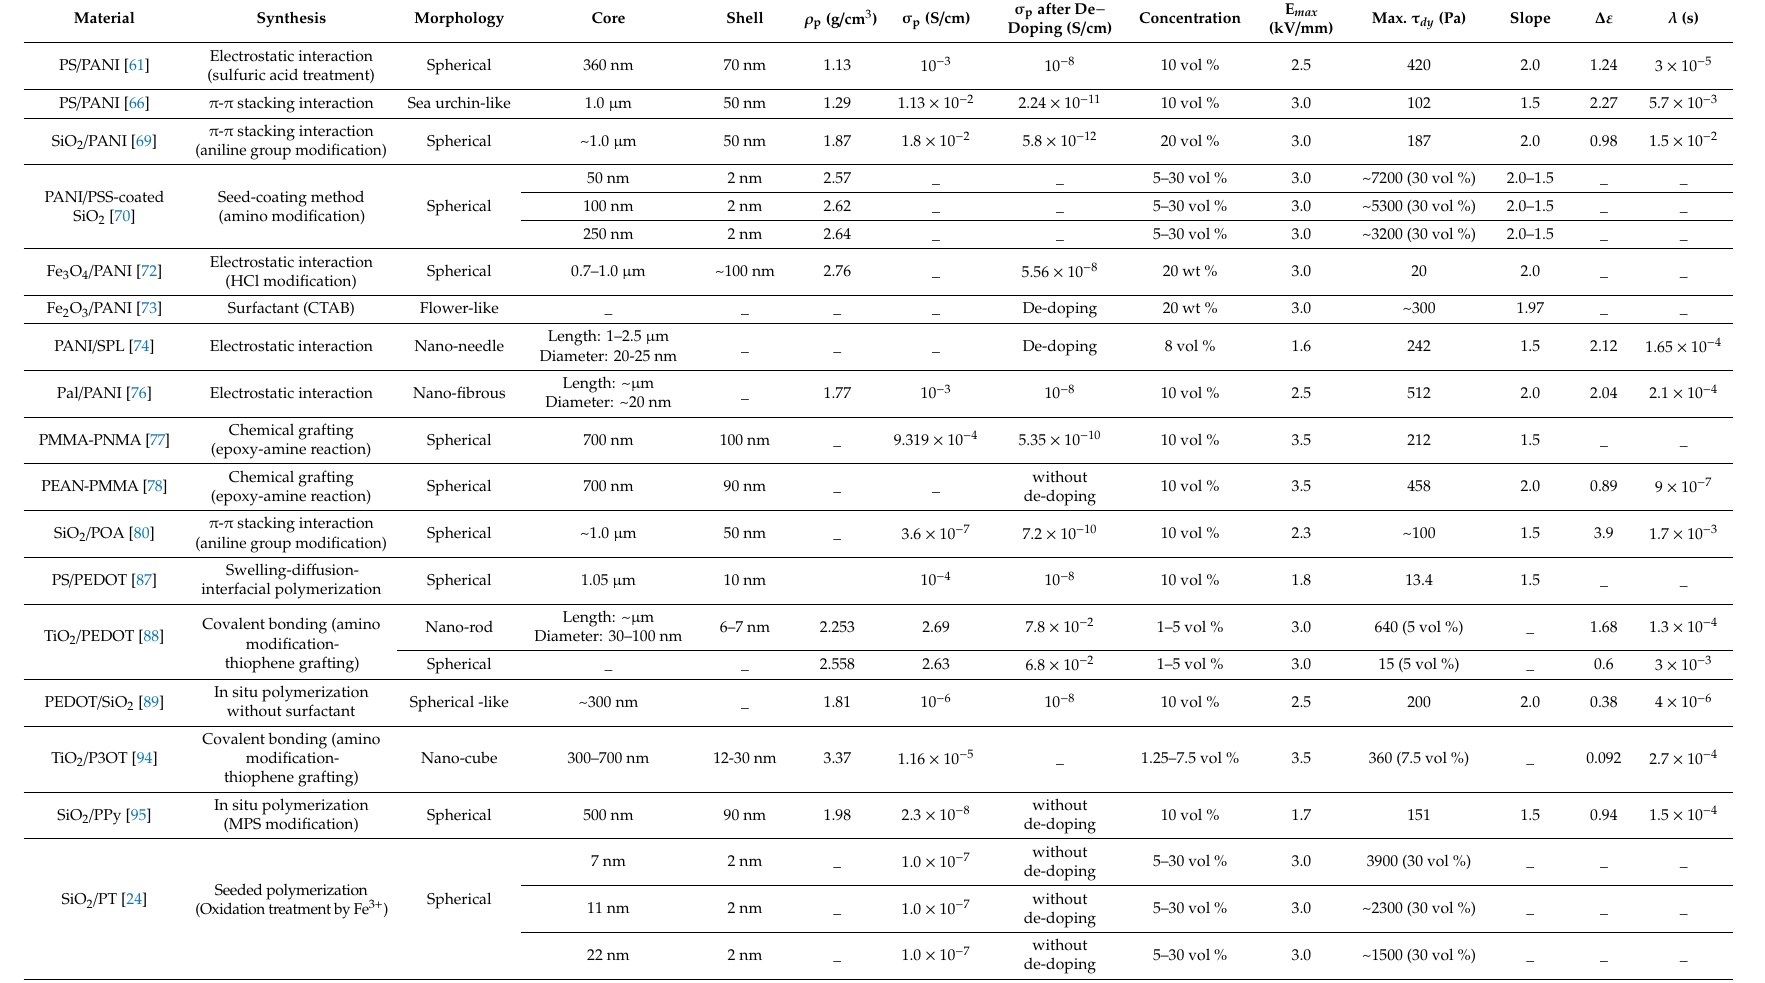
Table 2. Parameters of conducting polymer-coated nanoparticles applied to ER